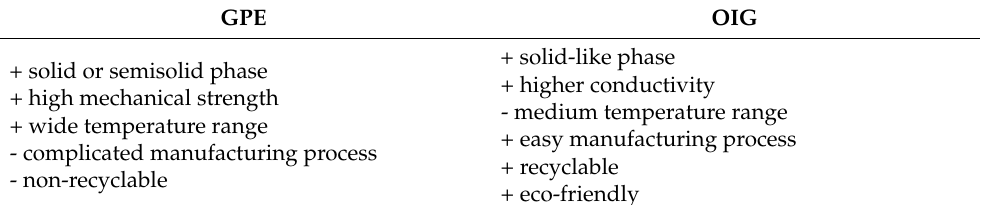
Table 1. The difference between GPE and